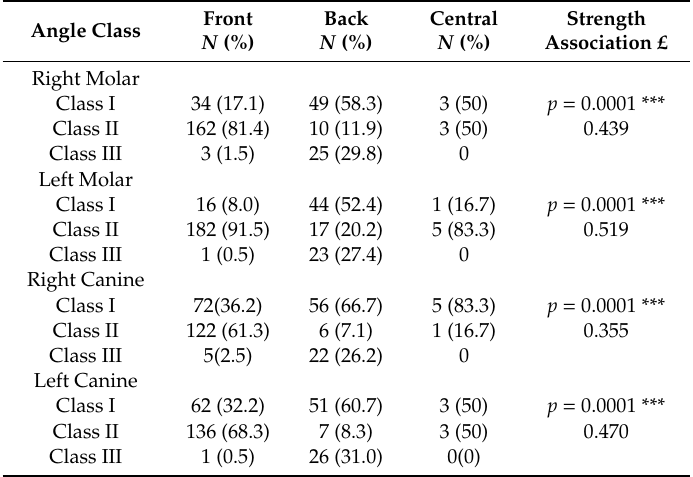
Table 4. Correlation between molar and canine class and centre of gravity of participants ( N = 289). Angle